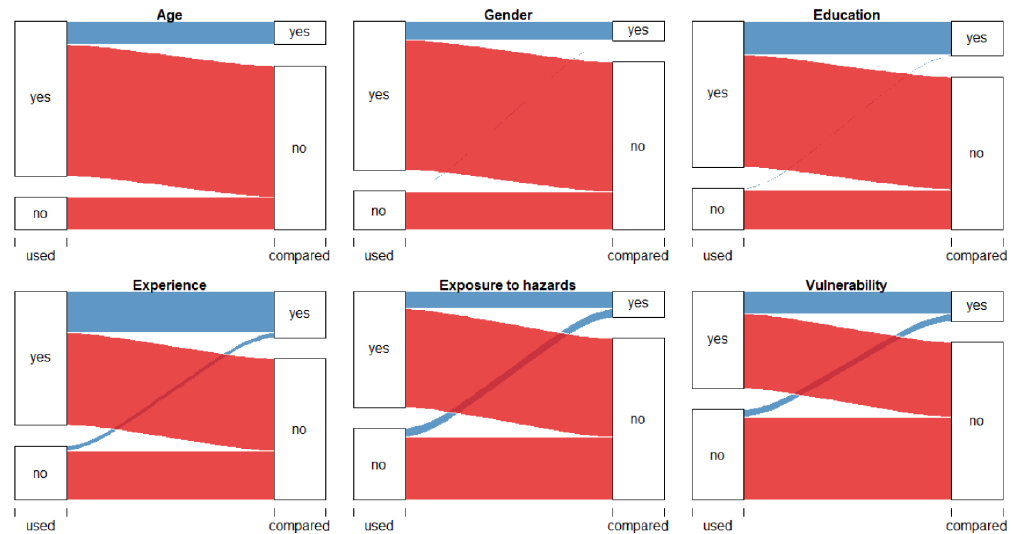
Figure 10. Explanatory variables used vs. mentioned as important for cross-study comparison. For instance, 124 respondents used age as an explanatory variable, but only 19 of them (15%) thought age was relevant for cross-study comparison.